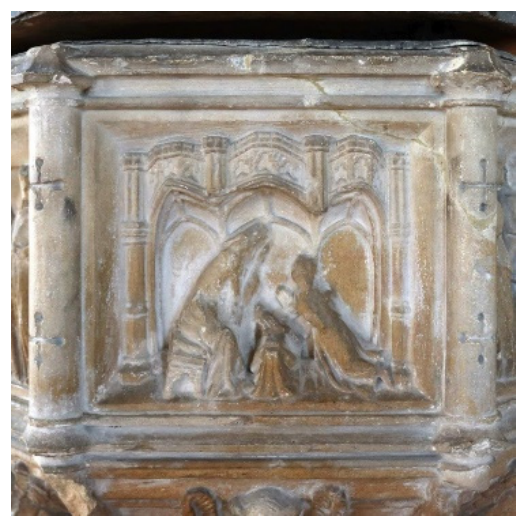
Figure 16. Penance. Source: Bob Mitchell.